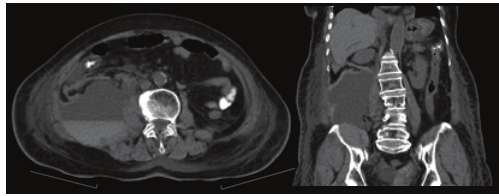
Figure 1: CT retroperitoneal hematoma (Case 1)—a large extra- peritoneal hematoma measuring 18.3 × 11.2 cm arising from the posterior surface of lower part of left rectus abdominis muscle and extending into the pelvis causing right sided displacement of pelvic organs.